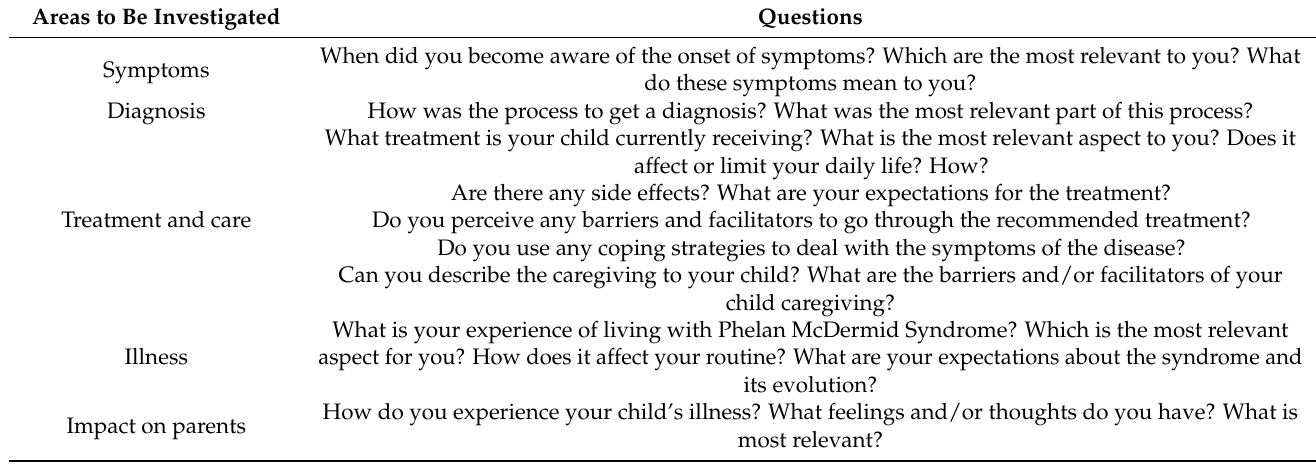
Table 1. In-depth interviews’ question